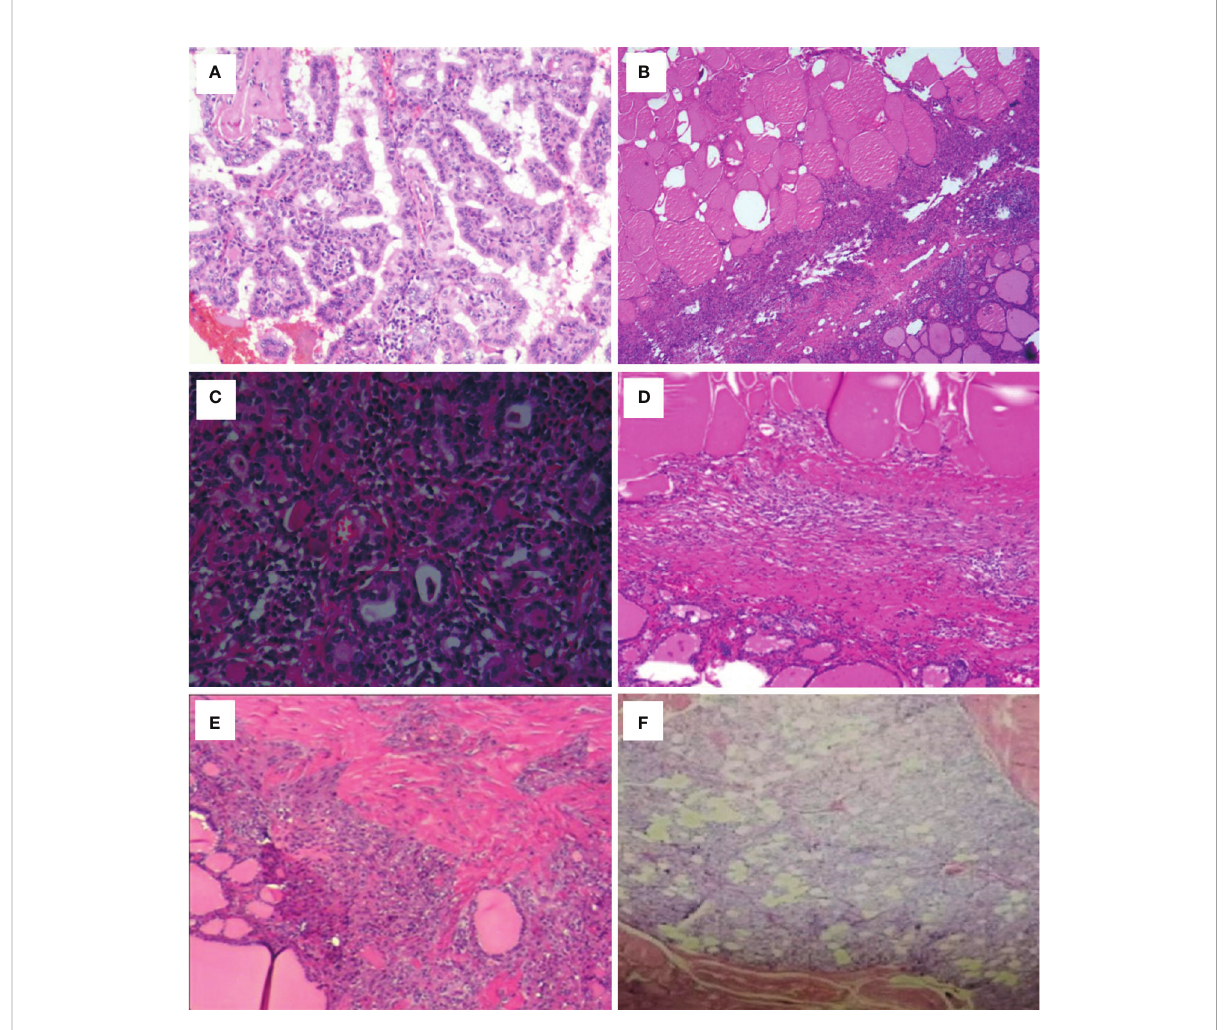
FIGURE 1 Post-ablation lesions of unifocal micro-PTC showed no residual carcinomas according to the postoperative pathology results (case 4 – 9). (A) Chronic in fl ammation in case 4. (B) Chronic in fl ammation and fi brosis in case 5. (C) Hashimoto ’ s thyroiditis and fi brosis in case 6. (D) Coagulative necrosis and fi brosis in case 7. (E) Fibrosis and nodular goiter in case 8. (F) Fibrosis and granuloma in case